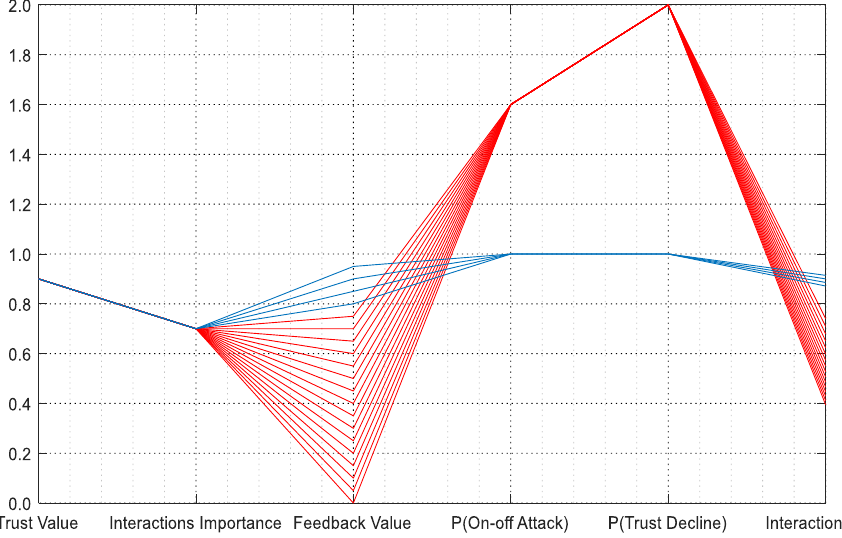
Figure 2. Penalties of on/off attack and trust decline.